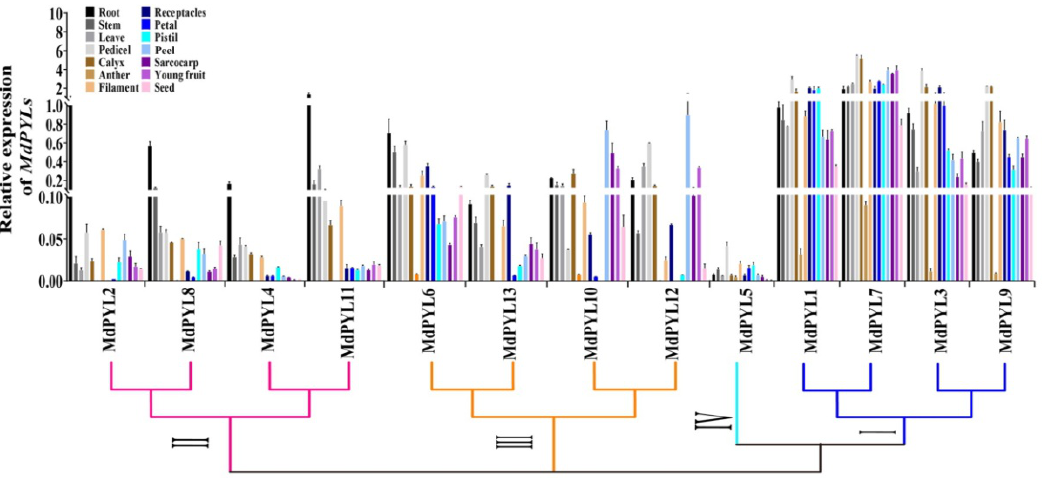
Figure 8. Tissue-specific expression of MdPYLs . Quantitative RT-PCR was performed on roots, stems, leaves, pedicels, calyxes, anthers, filaments, receptacles, petals, pistils, peels, sarcocarps, young fruits, and seeds. The expression of MdPYL2 in roots was set to 1 and MdActin was used as an internal control. The relative expression levels of genes were calculated based on the 2- ∆∆ Ct method, and values are the mean ± SD obtained from three biological